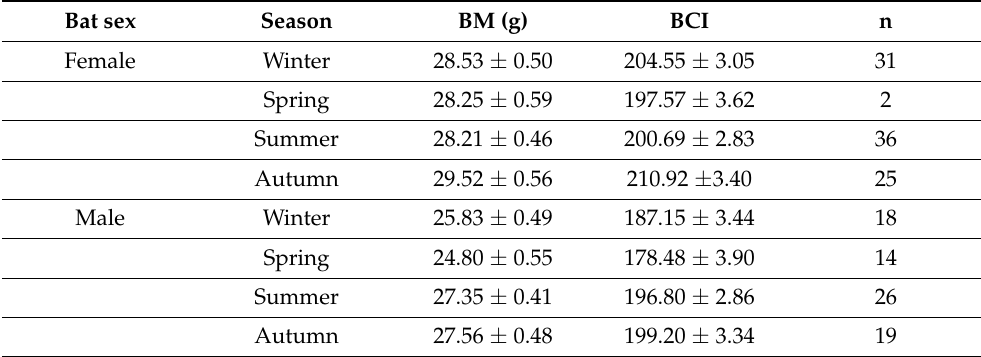
Table 1. Body mass (BM) and body condition index (BCI) of female and male fish-eating myotis ( Myotis vivesi ) during four seasons in Partida Norte Island, Mexico. The BCI was estimated using the scaled max index (Peig and Green 2009). Females with external signs of pregnancy were not included because their body mass was confounded by the body mass of the fetus. Values are mean ± SE. Bat sex Season BM (g) BCI n Female Winter 28.53 ± 0.50 204.55 ± 3.05 31 Spring 28.25 ± 0.59 197.57 ± 3.62 2 Summer 28.21 ± 0.46 200.69 ± 2.83 36 Autumn 29.52 ± 0.56 210.92 ± 3.40 25 Male Winter 25.83 ± 0.49 187.15 ± 3.44 18 Spring 24.80 ± 0.55 178.48 ± 3.90 14 Summer 27.35 ± 0.41 196.80 ± 2.86 26 Autumn 27.56 ± 0.48 199.20 ± 3.34 19 There were significant seasonal differences in the body mass among males (F 3, 73 = 6.70, p = 0.0004; Table 1): males in spring had a lower body mass than in autumn ( p = 0.002) and summer ( p = 0.002). Similarly, the BCI differed seasonally (F 3, 73 = 7.14, p = 0.0002; Table 1): males in spring had a lower BCI than in autumn ( p = 0.002) and summer ( p = 0.007). Most males captured in autumn had scrotal testicles (October 2013: n = 14; November 2013: n = 3), with a few individuals with abdominal testicles (October 2013: n = 2). In winter (December 2012: n = 5; February 2014: n = 13), spring (April 2013: n = 6; April 2014: n = 6), and summer (July 2013: n = 11; July 2014: n = 14), all males had abdominal testicles. There were significant differences in the testosterone content among seasons (F 2, 41 = 71.36, p < 0.0001; Figure 1E): males in autumn had higher values than in summer ( p = 0.0001) and winter ( p =